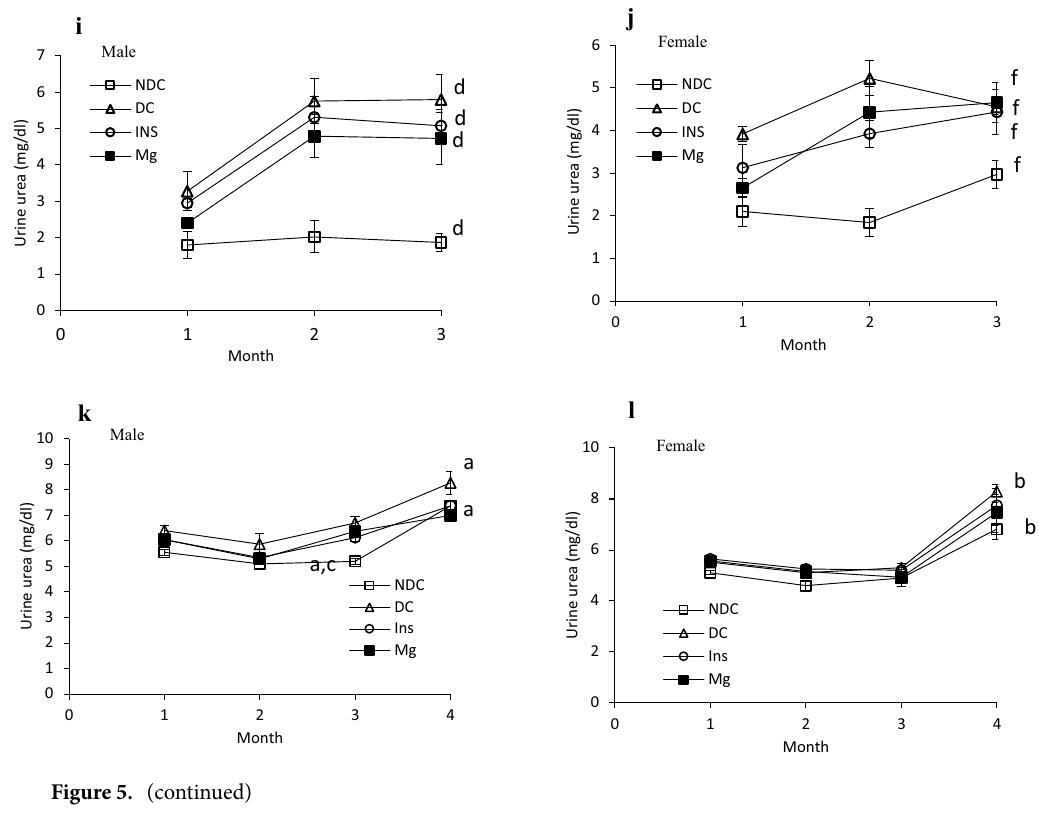
group 15.7 ± 4.1 mg/dl). Administration of MgSO 4 or insulin for 3 months significantly decreased ( p < 0.001) urinary albumin excretion in both parents in compared to both DC groups (male Mg-treated 21.8 ± 6.3 mg/dl, female Mg-treated 27.5 ± 0.8, male insulin-treated 31.25 ± 3.3 mg/dl and female insulin-treated 29.5 ± 2.5 mg/dl). Significant differences were not observed between insulin and MgSO 4 treated groups in both